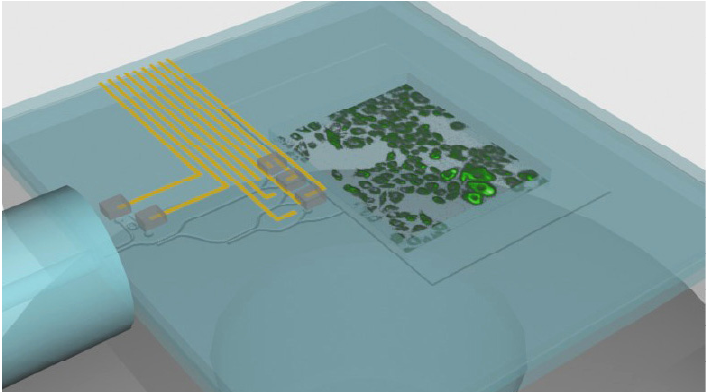
Figure 4. Simplified schematic view of a possible chip layout containing a single sample well, monitoring of fiber alignment and temperature, as well as splitting and individual shuttering of three excitation wavelengths using directional couplers and digital optical switches (micro-incubator assembly not shown). In the depicted set-up, fluorescence from cells in the sample well is collected from below using an inverted microscope